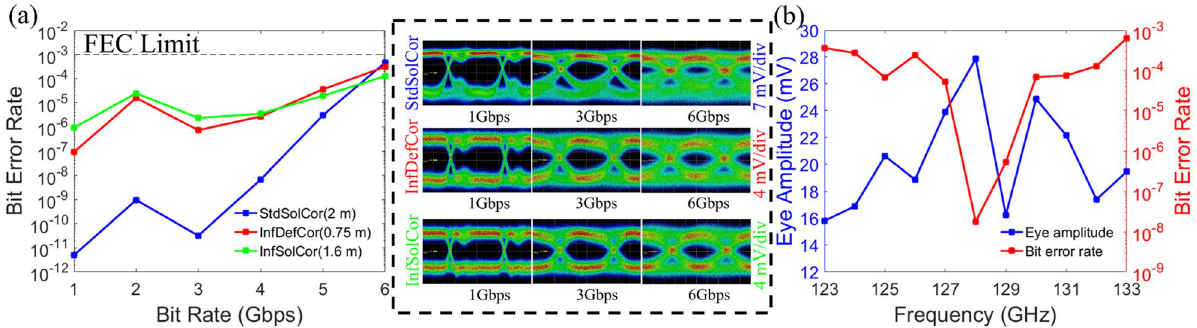
Figure 8. ( a ) Measured bit error rate versus bit rate for StdSolCor (2 m), InfDefCor (0.75 m), and InfSolCor (1.6 m) at the carrier frequency of 128 GHz. Inset: The recorded eye pattern for different bit rates. ( b ) Measured eye amplitude and bit error rate for StdSolCor (2 m) at the bit rate of 4 Gbps as a function of